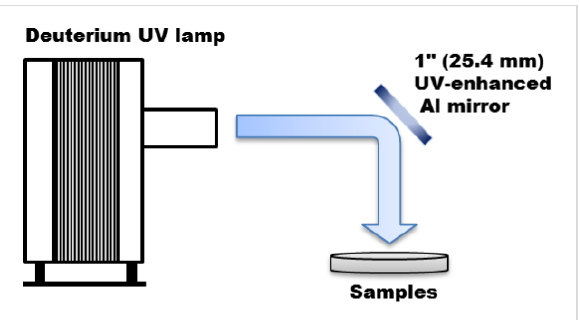
Figure 6: Set-up for UV exposure on the samples using a deuterium UV lamp with diverted beam set-up using an UV-enhanced aluminium flat